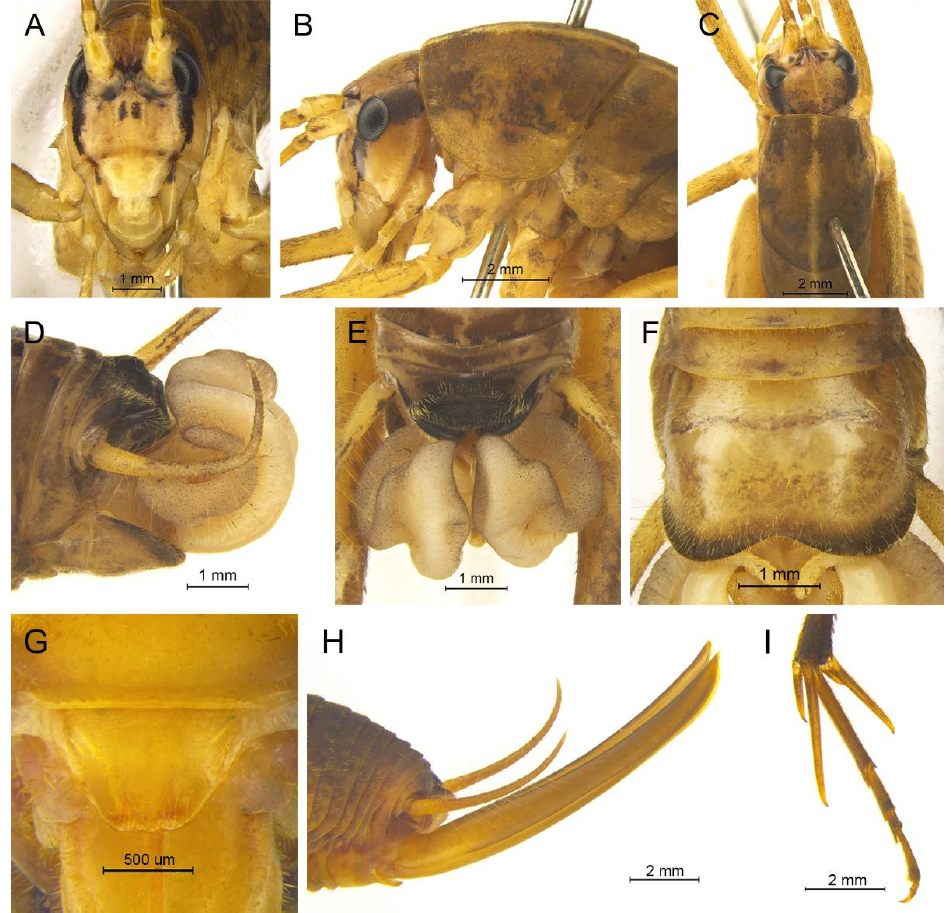
Figure 25. Homotachycines concavus Zhu & Shi sp. nov., male: ( A – C ) head and pronotum: ( A ) frontal view, ( B ) lateral view, ( C ) dorsal view; ( D – F ) apex of abdomen: ( D ) lateral view, ( E ) dorsal view, ( F ) ventral view; ( I ) hind tarsus in lateral view; female (nymph): ( G ) subgenital plate in ventral view; ( H ) ovipositor in lateral view.